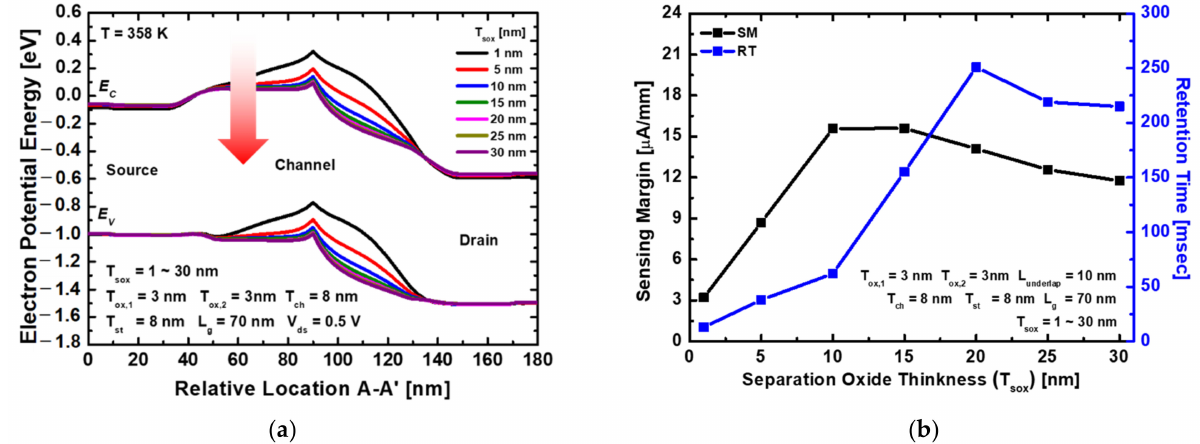
Figure 11. ( a ) Energy band diagram of the channel layer with different T sox during the read operation. The energy band is extracted at 2 nm above the bottom gate oxide. ( b ) Variations in sensing margin and retention time with T sox of proposed 1T-DRAM.